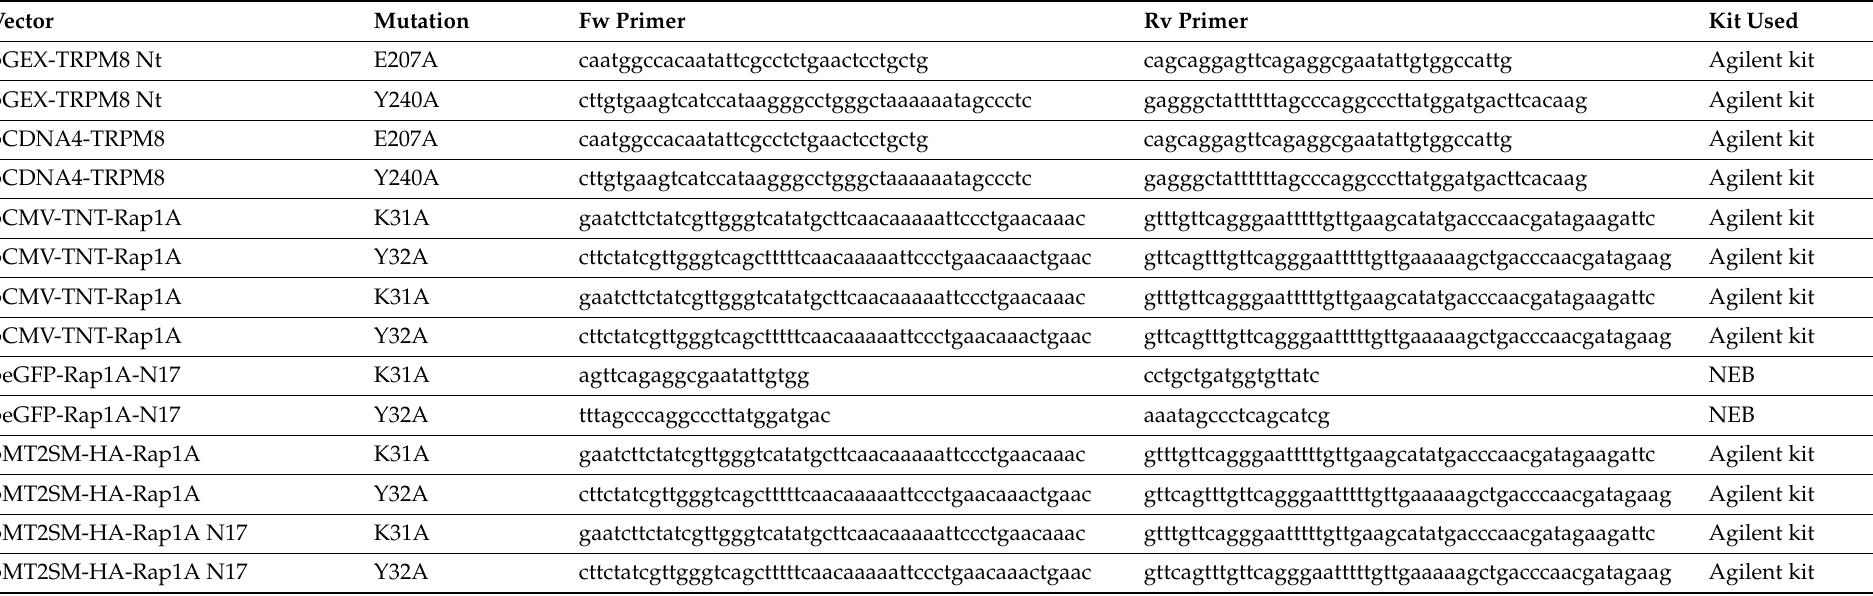
Table 1. Primers sequences used for single and double mutagenesis of TRPM8 (E207A and Y240A) and Rap1 (K31 and